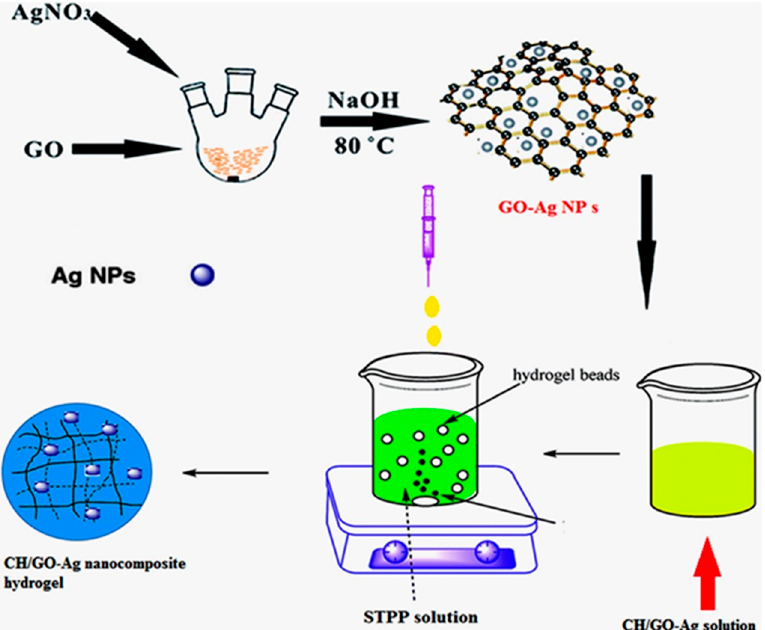
Figure 2. Schematic of facile preparation of bio-nanocomposite based on chitosan (Ch) and graphene oxide (GO) and silver (Ag) nanohybrids for controlled release of an anticancer drug [43].